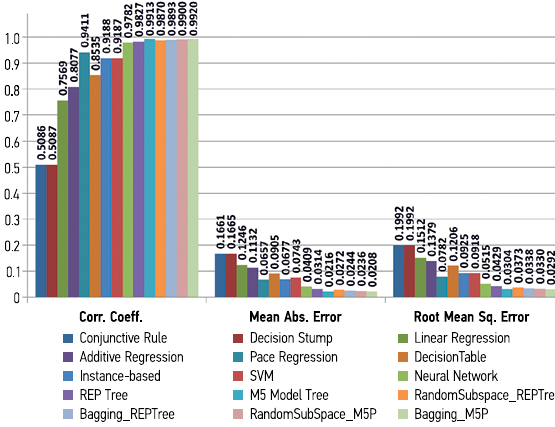
Fig. 5. Summary of subgrade layer moduli ( E ri ) prediction performance with data mining techniques using theoretic deflection basins